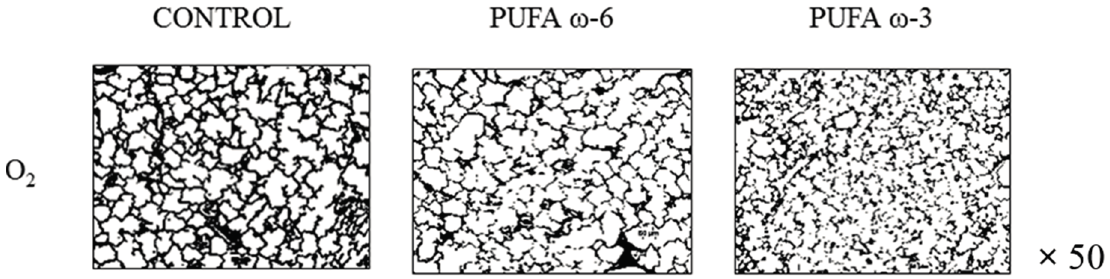
Figure 3. Lung sections showing impaired alveolization with decrease of septation and enlargement of distal airspaces in control/O 2 and PUFA ω -6/O 2 ; and increase of alveoli/fields and decrease of alveolar size in PUFA ω -3/O 2 . ×50: enlarge fifty times. Chronic exposure to hyperoxia was associated with a significant decrease in septation with halving of secondary alveolar septa ( p < 0.01) in newborn rats of control/O 2 (4.8 ± 0.4) and PUFA ω -6/O 2 (5.2 ± 0.2) groups compared to control/air (9.7 ± 0.7) and PUFA ω -6/air (9.4 ± 0.4) (Figure 4A). We observed a significant increase in the mean interalveolar distance (in µm) (PUFA ω -6/air: 41.5 ± 1.9 vs . PUFA ω -6/O 2 : 62.2 ± 1.9 and control/air: 40 ± 2.6 vs . control/O 2 : 60.9 ± 3.9) of almost 50% (corresponding to enlargement of airspaces) ( p < 0.01) (Figure 4B) and of the thickness of the interstitium (in µm) (PUFA ω -6/air: 4.5 ± 0.3 vs . PUFA ω -6/O 2 : 6.8 ± 0.4 and control/air: 4.8 ± 0.3 vs